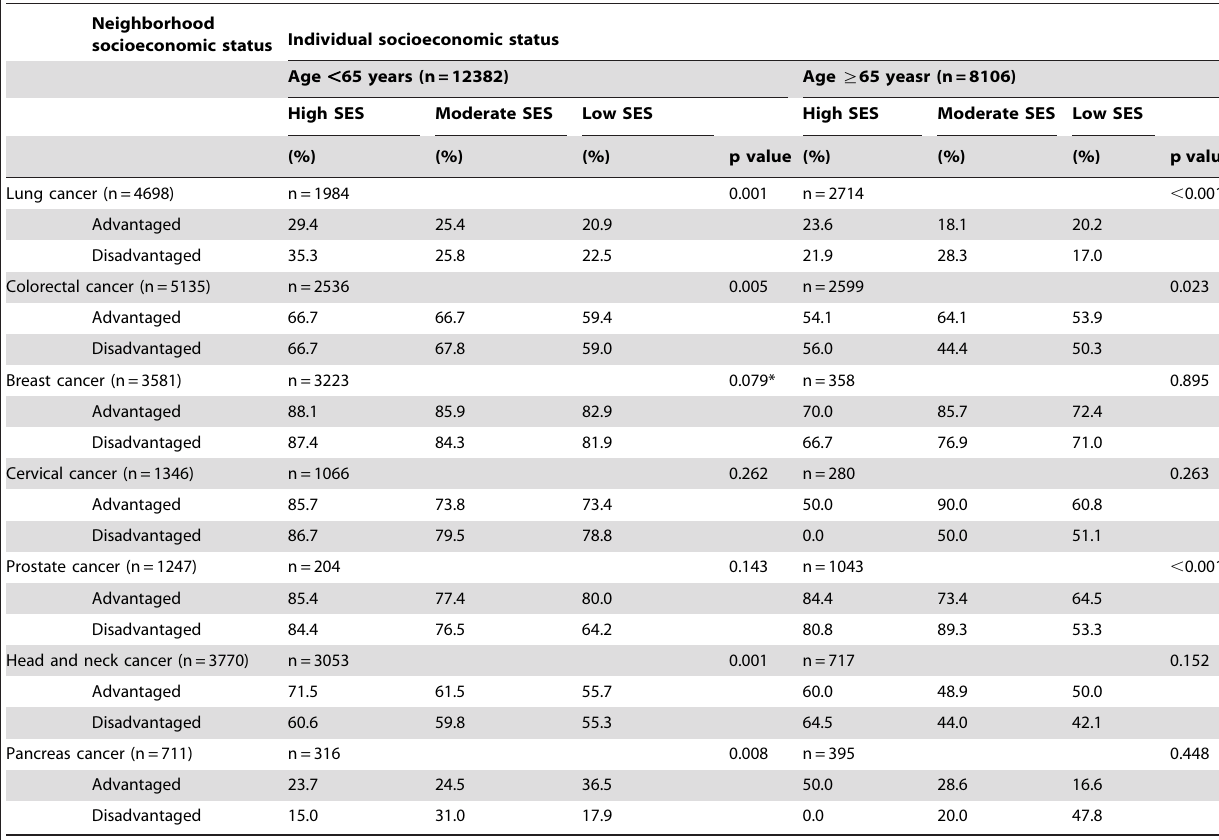
Table 2. Combined effect of individual SES and neighborhood SES on 5-year overall survival rates(n =20488).